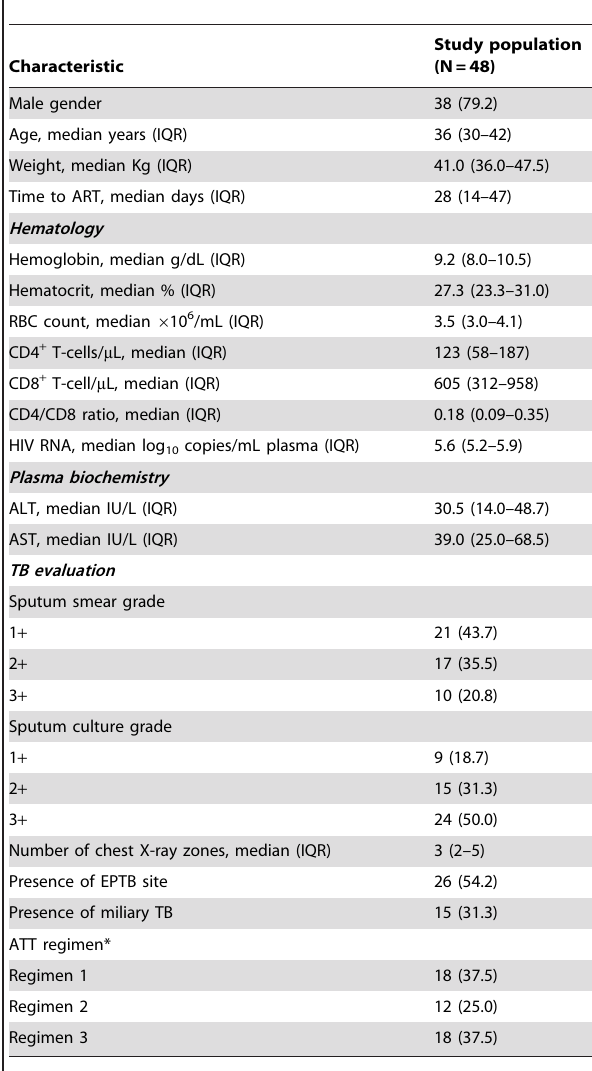
Table 1. Baseline characteristics of the study